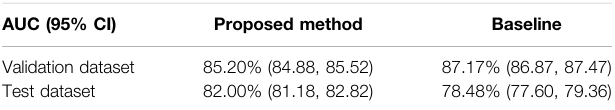
TABLE 4 | AUC results of the proposed method and baseline AUC on the balanced